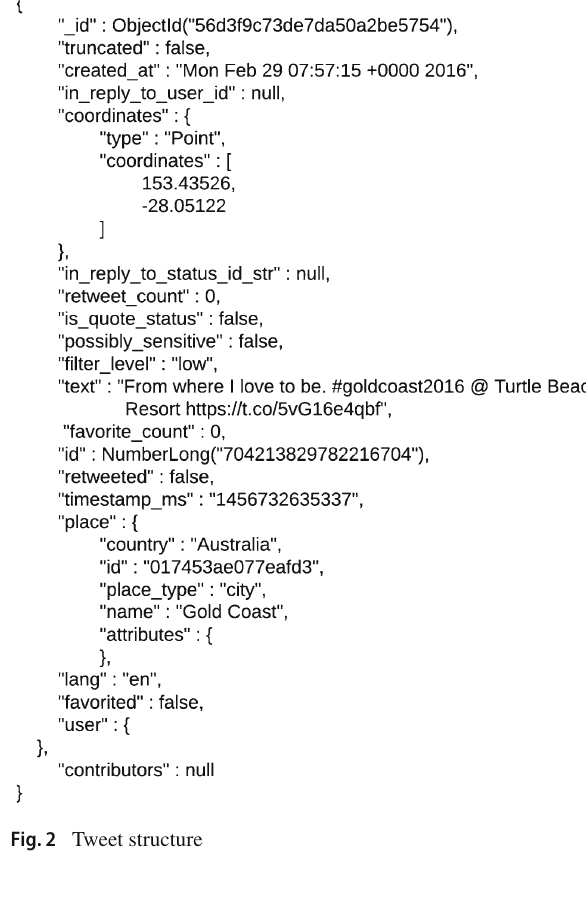
Database platform MongoDB is an open source